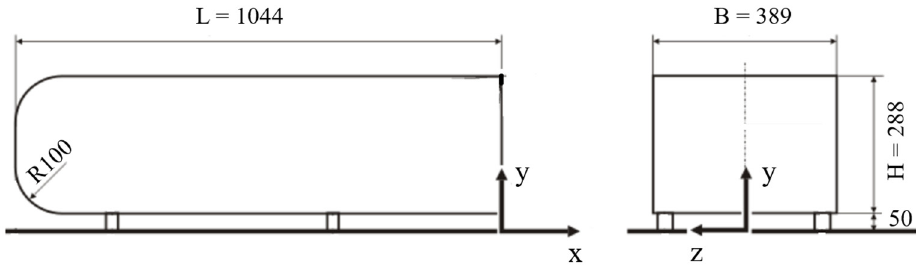
Figure 1. The square-back Ahmed model and dimensions in mm.